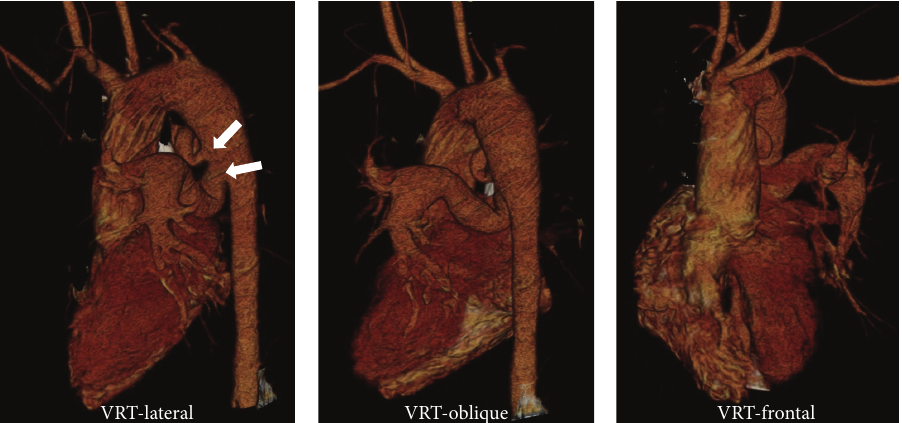
Figure 6: 3D volume rendered images in lateral, oblique, and frontal projections showing large arterial channels arising from the left lateral aspect of the descending thoracic aorta (arrows) on the lateral projection representing MAPCAs. Overriding of aorta appreciated on the frontal